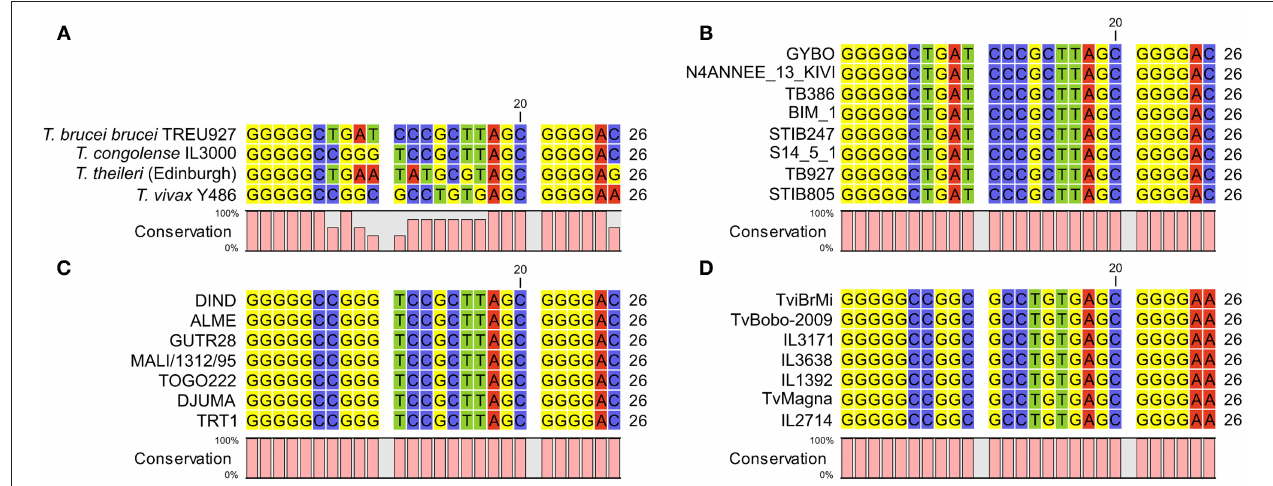
FIGURE 5 | (A) alignment of 7SL sRNA sequences from African trypanosomes and the commensal Trypanosoma theileri . Consistent with the African trypanosomes previously analyzed, the T. theileri 7SL sRNA sequence exhibits highly conserved flanking regions with a variable internal sequence, which importantly does not match that of the other trypanosome species. (B) 7SL sRNA sequences alignment in representative T. brucei subspecies isolates (from a total of 88 analyzed). Genome data were obtained from a previous study (34) (ENA accession: PRJEB2486) or from TriTrypDB. Strain information: GYBO: T. b. rhodesiense , isolated in 1984 in Tanzania; N4ANNEE_13_KIVI: T. b. gambiense group I, 2002, Guinea; TB386: T. b. gambiense group II, 1978, Côte d’Ivoire; BIM_1: T. b. gambiense group I, 1975, Cameroon; STIB247: T. b. brucei , 1971, Tanzania; S14_5_1: T. b. gambiense group I, 2002, Côte d’Ivoire; TB927: T. b. brucei , 1969 Kenya; STIB805: T. b. evansi , 1985, China. (C) 7SL sRNA sequence alignments in T. congolense isolates. Data from 55 genomes were obtained from a previous study (35) (ENA accession: PRJEB15251), and a representative subset is shown. Strain information (Savannah subtype unless stated): DIND: Forest subtype, 1986, Burkina Faso; ALME: 2005, Cameroon;